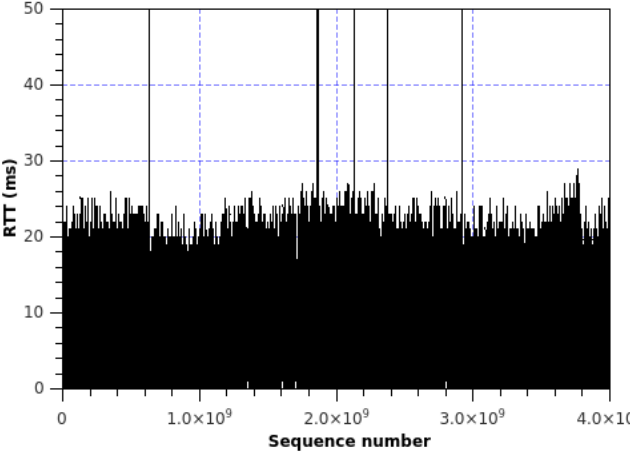
Figure 12. TCP session throughput on router with a modified Linux kernel.